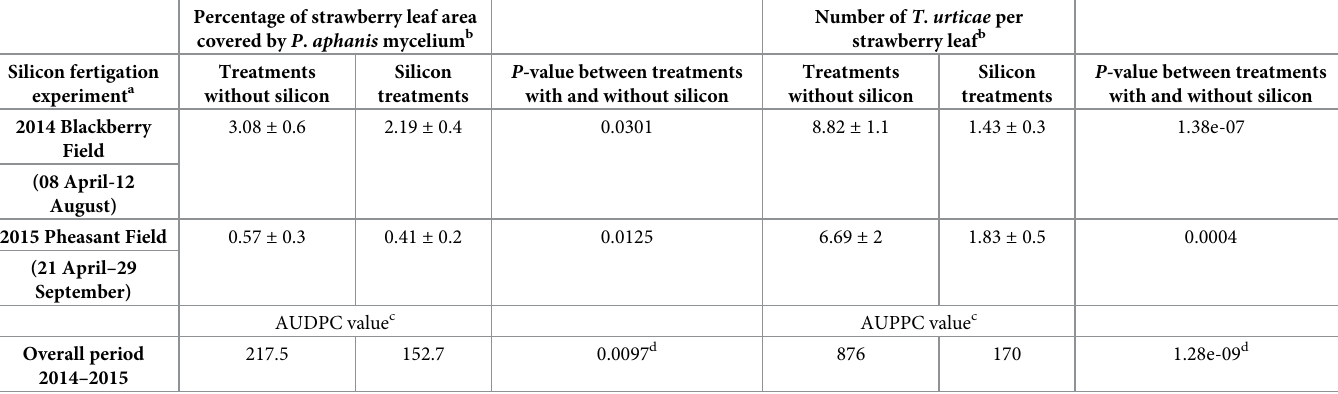
Table 3. Overall analysis of strawberry powdery mildew symptoms and two-spotted spider mites infestation results in 2014 and in 2015. Percentage of strawberry leaf area covered by P . aphanis mycelium b Treatments Silicon P -value between treatments without silicon treatments with and without silicon